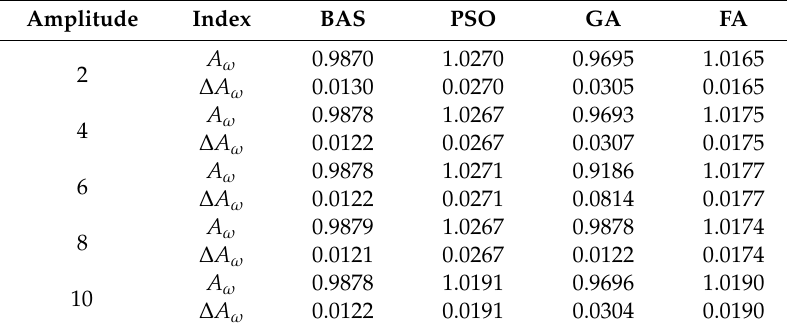
Table 4. Frequency response characteristics.